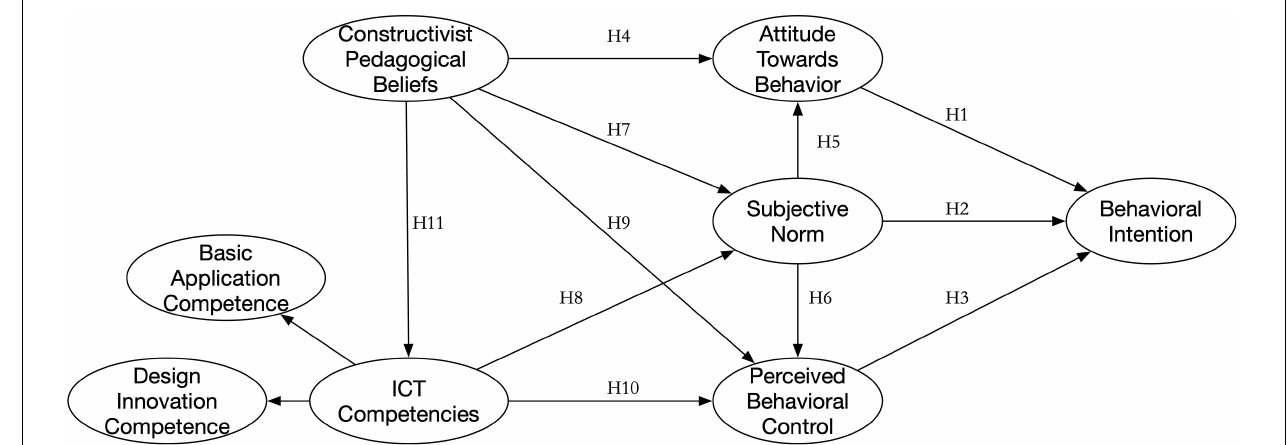
FIGURE 1 | Research model of an extended theory of planned